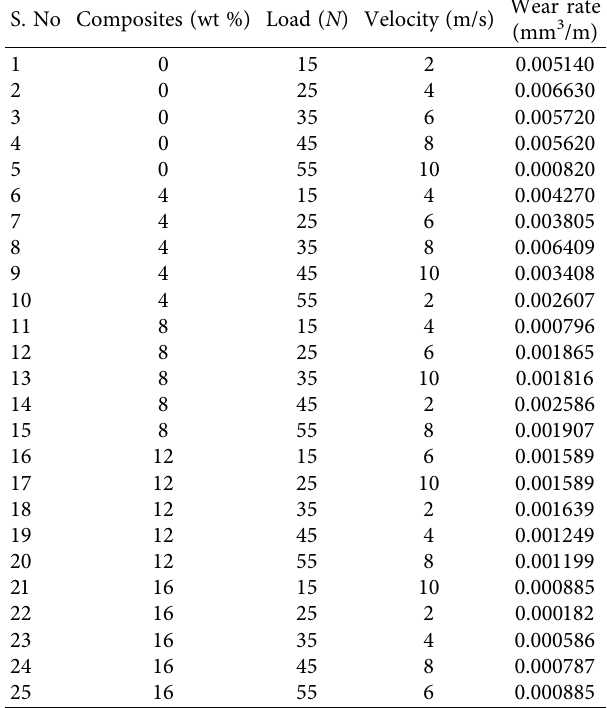
Table 4: Experimental runs input and output values.